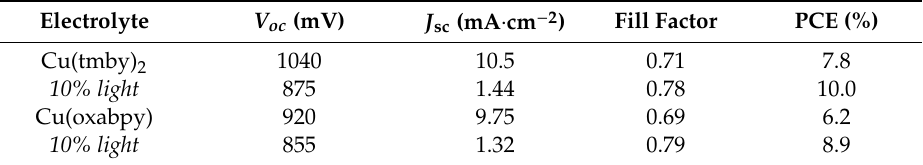
Table 1. J – V characteristics for Y123-sensitized solar cells with Cu(tmby) 2 and Cu(oxabpy) electrolyte under full AM 1.5 G and under 10% light intensity. For detailed characterization, the reader is referred to Figures S6–S9 in the Supporting